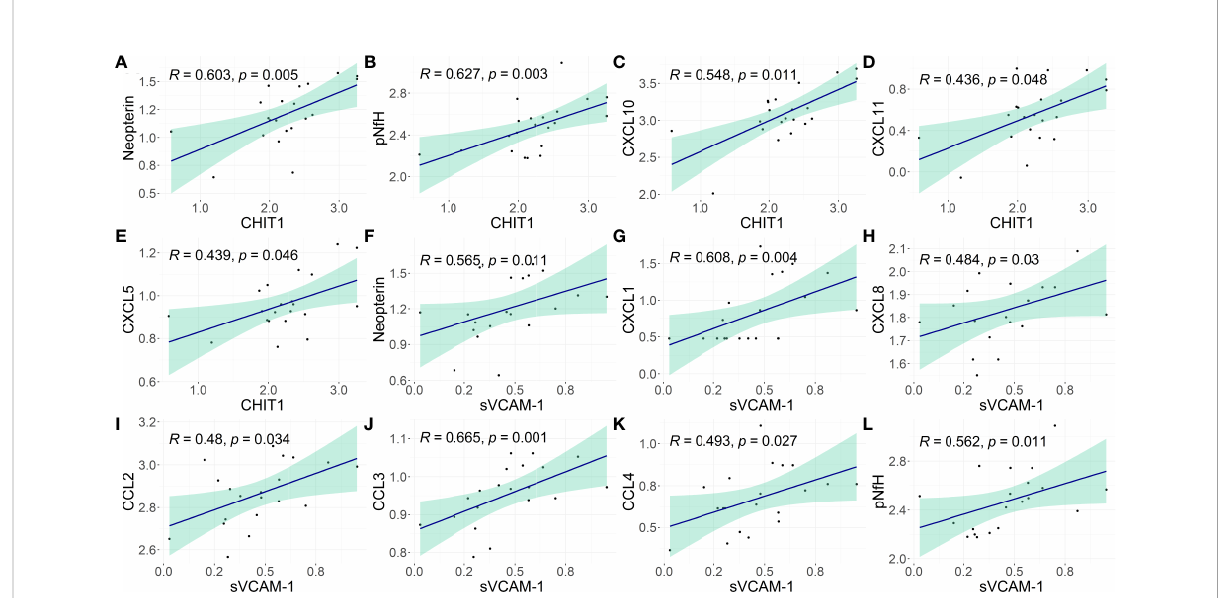
FIGURE 3 Association of CHIT1 and sVCAM-1 with biomarkers of neuroin fl ammation and neuronal damage in the CSF of HAM/TSP patients. The correlation between the CSF concentration of (A – E) CHIT1 and (F – L) sVCAM-1 with neopterin, phosphorylated neuro fi lament heavy chain (pNfH) protein, and proin fl ammatory chemokines (CCL2, CCL3, CCL4, CXCL1, CXCL5, CXCL8, CXCL10, and CXCL11) was performed with Spearman ’ s rank of correlations test. The biomarkers of neuroin fl ammation or neuronal damage were assessed in this population in a previous study (25). The concentration values were log 2 -transformed and p -values <0.05 were considered signi fi